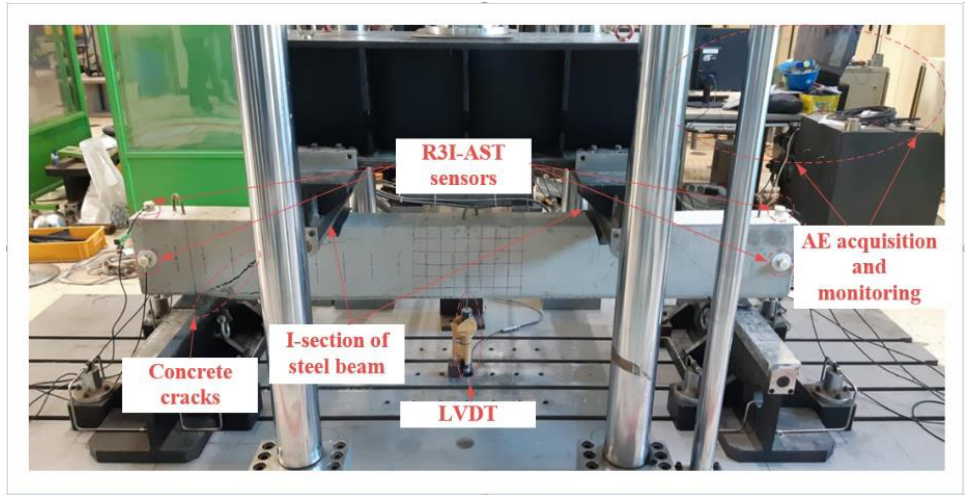
Figure 9. Pictogram of the four-point bending test.